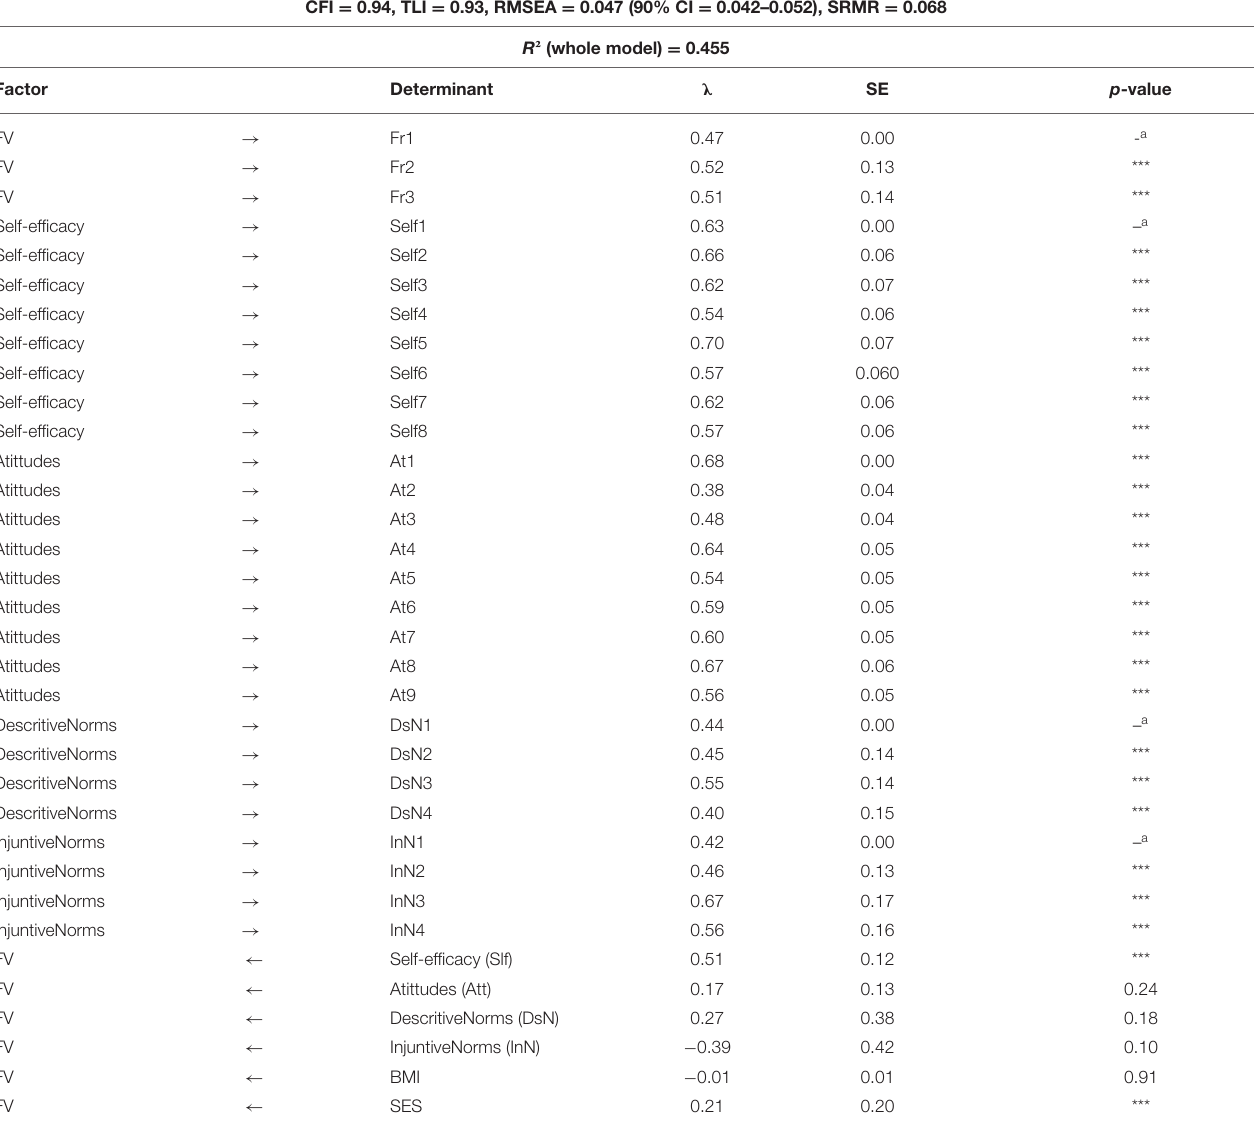
a Based on Structural Equation Modeling (SEM) for a structural model. CFI, Comparative Fit Index; TLI, Tucker-Lewis Index; RMSEA, Root Mean Square Error of Approximation [90% ConfidenceInterval(CI)];SRMR,StandardizedRootMeanSquareResidual;BMI,BodyMassIndex;SES,SocioeconomicStatus; *** p < 0.001. a Dashedlinesrepresentnon-standardized estimates that were constraint to one as reference to the